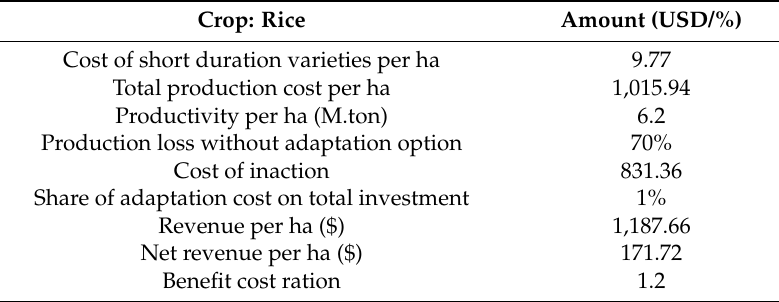
Table 7. Economic analysis of adopting short duration rice